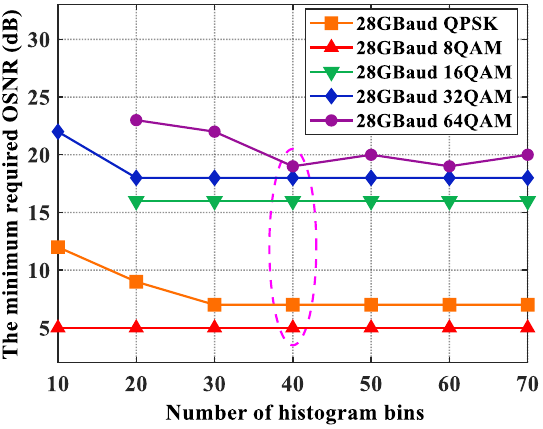
Figure 9. Minimum required OSNR values with different numbers of histogram bins for five modulation formats; 40 bins is the optimum selection.